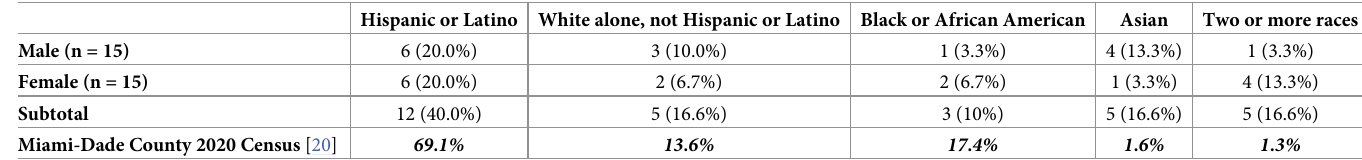
Table 3. Summary of subjects’ race and ethnicity. All the data are reported as number of subjects and percentages based on the total (n = 30). Data are compared to Miami-Dade County demographics as per 2020 Census. Hispanic or Latino White alone, not Hispanic or Latino Black or African American Asian